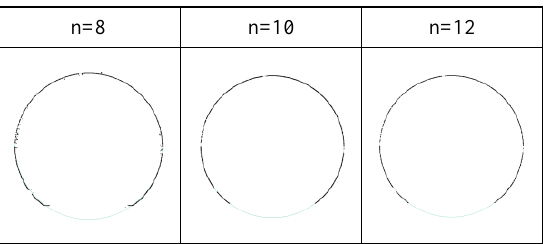
Table 3. Result of different number of iterations